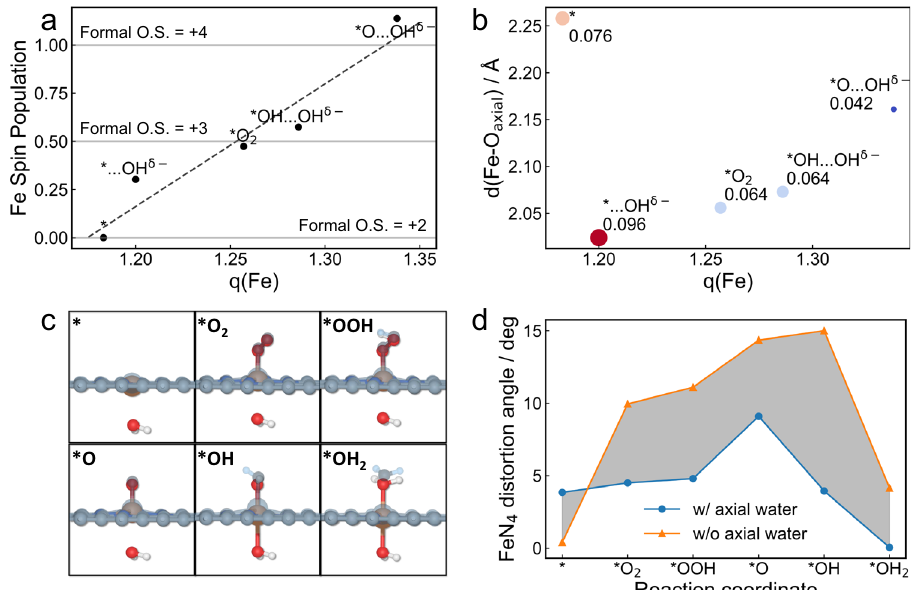
Fig. 6 Effects on the catalytic center induced by the backside axial water. a The scatter plot of Mulliken spin population versus the Bader charges on Fe along the reaction coordinate. The fi tted linear correlation is shown in black dashed line, and the formal oxidation states of Fe are marked by gray lines. b The scatter plot of Fe – O axial distances versus the Fe Bader charges. The charge transfer from backside axial water is labeled next to each data point. c Overlapped geometries of gas phase reaction intermediates with (colored) or without (transparent blue) backside axial water ligand. d The evolution of FeN 4 distortion angle along the reaction coordinate for gas phase reaction intermediates with(blue lines) or without(orange lines) backside axial water ligand. The shaded area represents the difference of FeN 4 distortion angle in the two